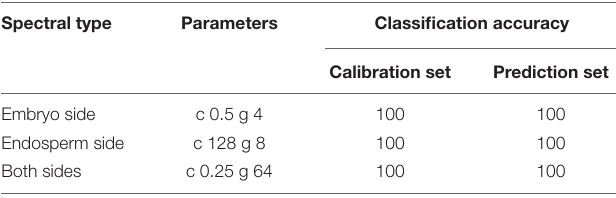
TABLE 2 | The results of feature wavelength selection from different spectral types based on loading of PC3.